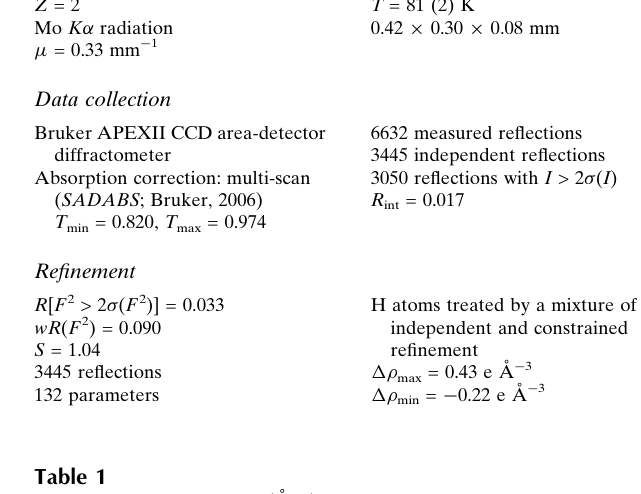
Hydrogen-bond geometry (A˚ , (cid:1)